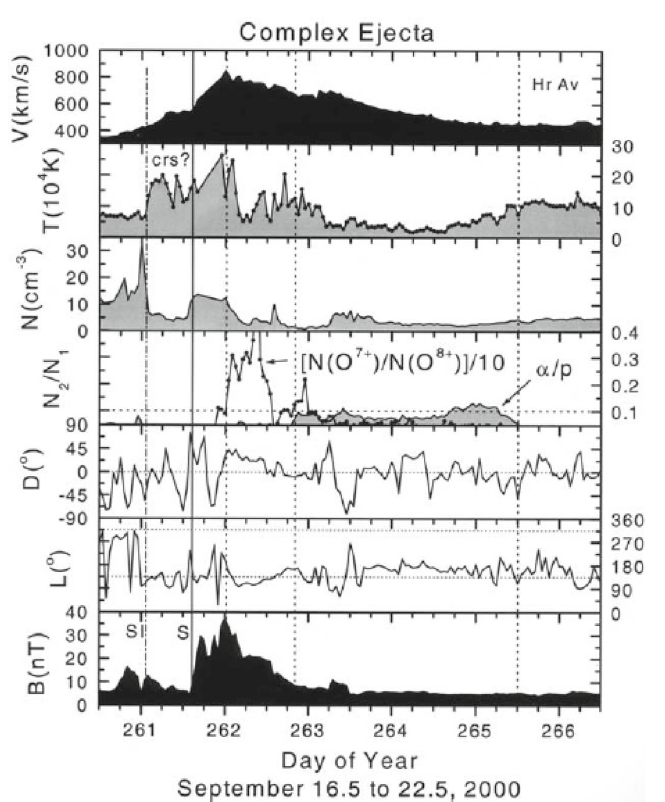
Fig. 29 A complex ejecta. The panels show from top to bottom: solar wind speed, temperature, density, alpha to proton and O + 8 / O + 7 ratio, elevation and azimuth angle of the magnetic field, and magnetic field magnitude. Image reproduced by permission from Burlaga et al. (2002), copyright by